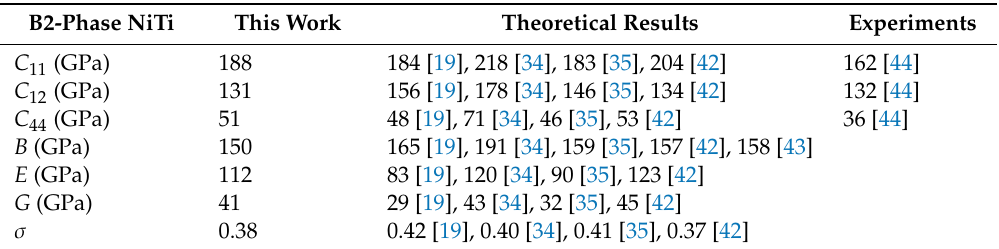
Table 3. Comparisons of the calculated results to the theoretical and experimental results for the B2-phase NiTi SMA.